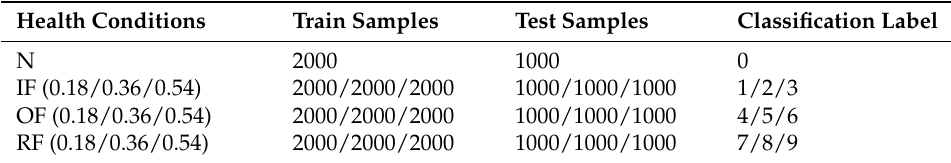
Table 4. Description of bearing dataset.